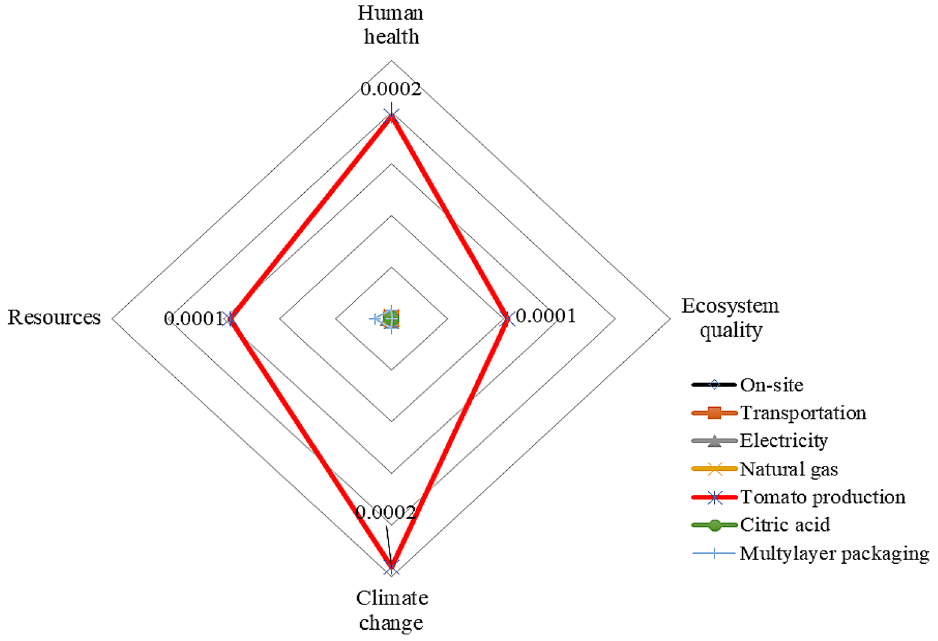
Figure 6. Normalized values of inputs damages in CTwJ processing and packaging for the ohmic heating